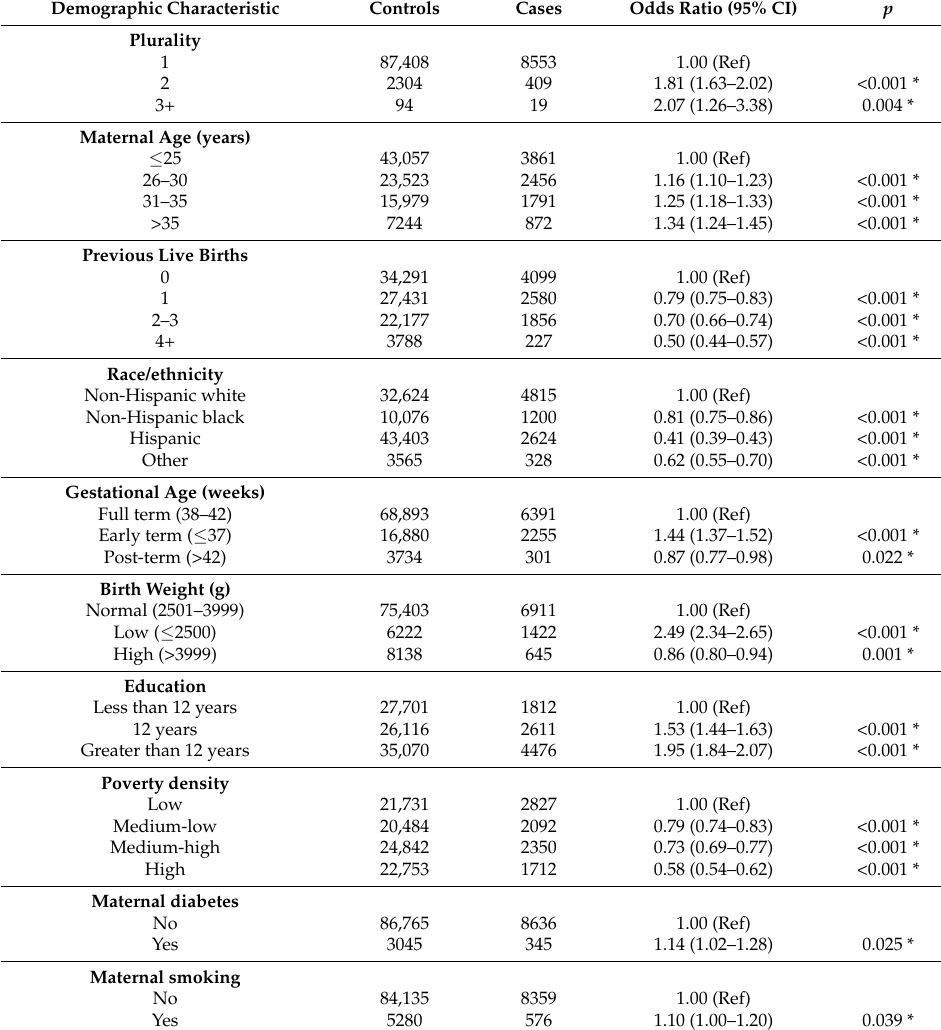
Table 1. Demographics of hypospadias cases and control patients in